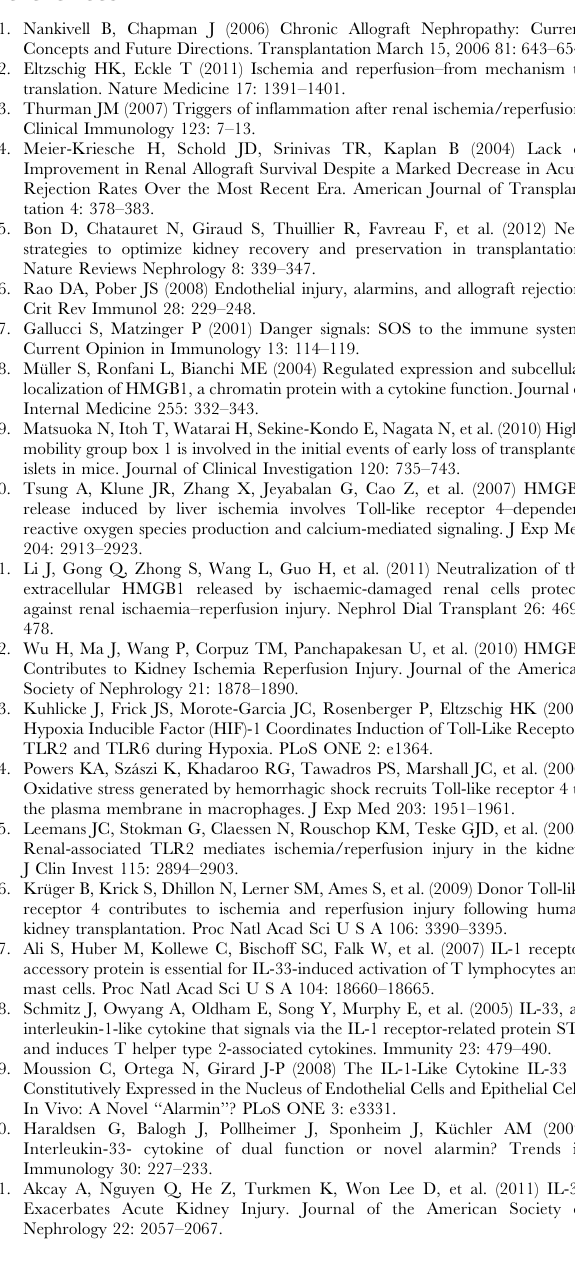
Figure S1 Up-regulation of sST2 mRNAs in PBMCs after renal IRI. Human PBMCs were recovered before transplantation (D0) as control time, and 30 minutes (H0.5), 3 hours (H3), day 1 (POD1), and day 3 (POD3) after transplanta- tion. Total RNA was extracted from PBMCs at the indicated time points and expression of sST2 mRNAs was quantified by RT- qPCR. Results are expressed as means 6 SEM (n= 22) of fold change relative to D0. *p , 0.05, **p , 0.01, ***p , 0.001 vs D0 by Wilcoxon test. Table S1 Primers used for real-time RT-PCR in human blood